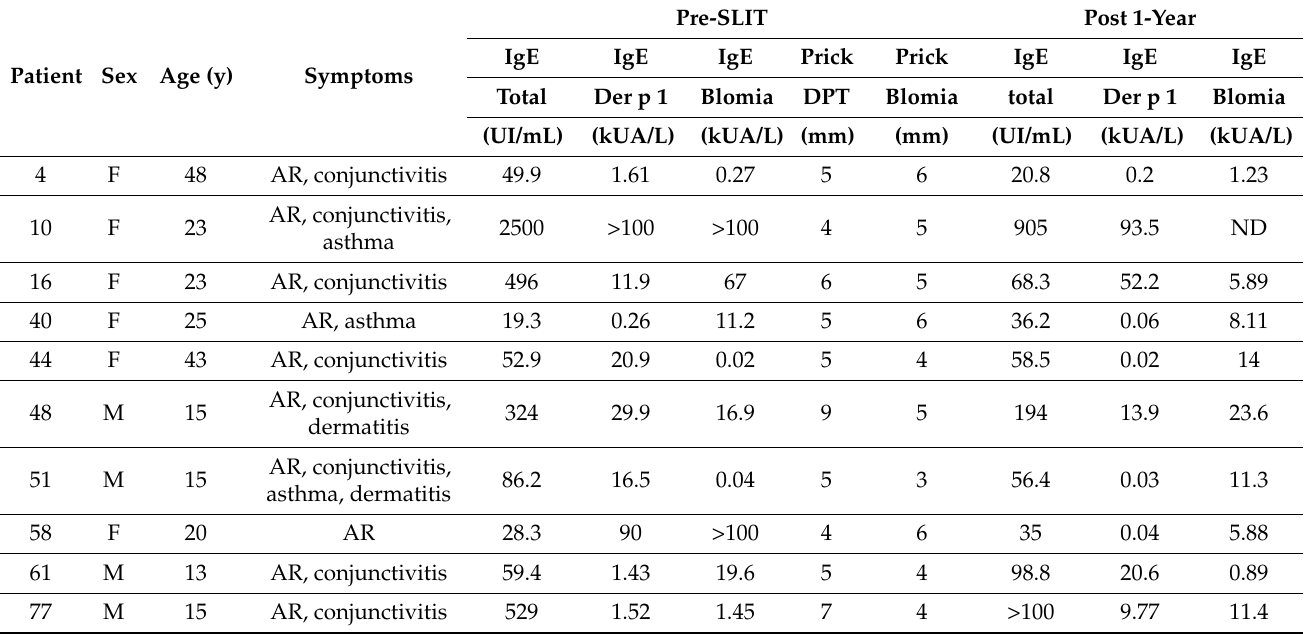
Table 1. Demographic and clinical data from selected patients.